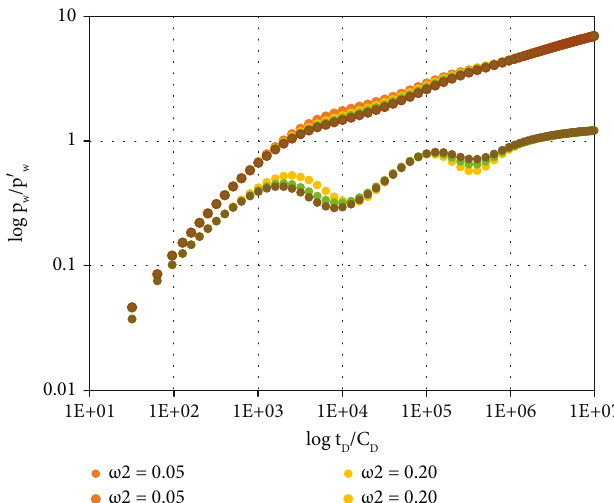
Figure 8: The in fl uence of the elastic storage capacity ratio of the outer zone on pressure di ff erence and pressure di ff erence derivative curve.